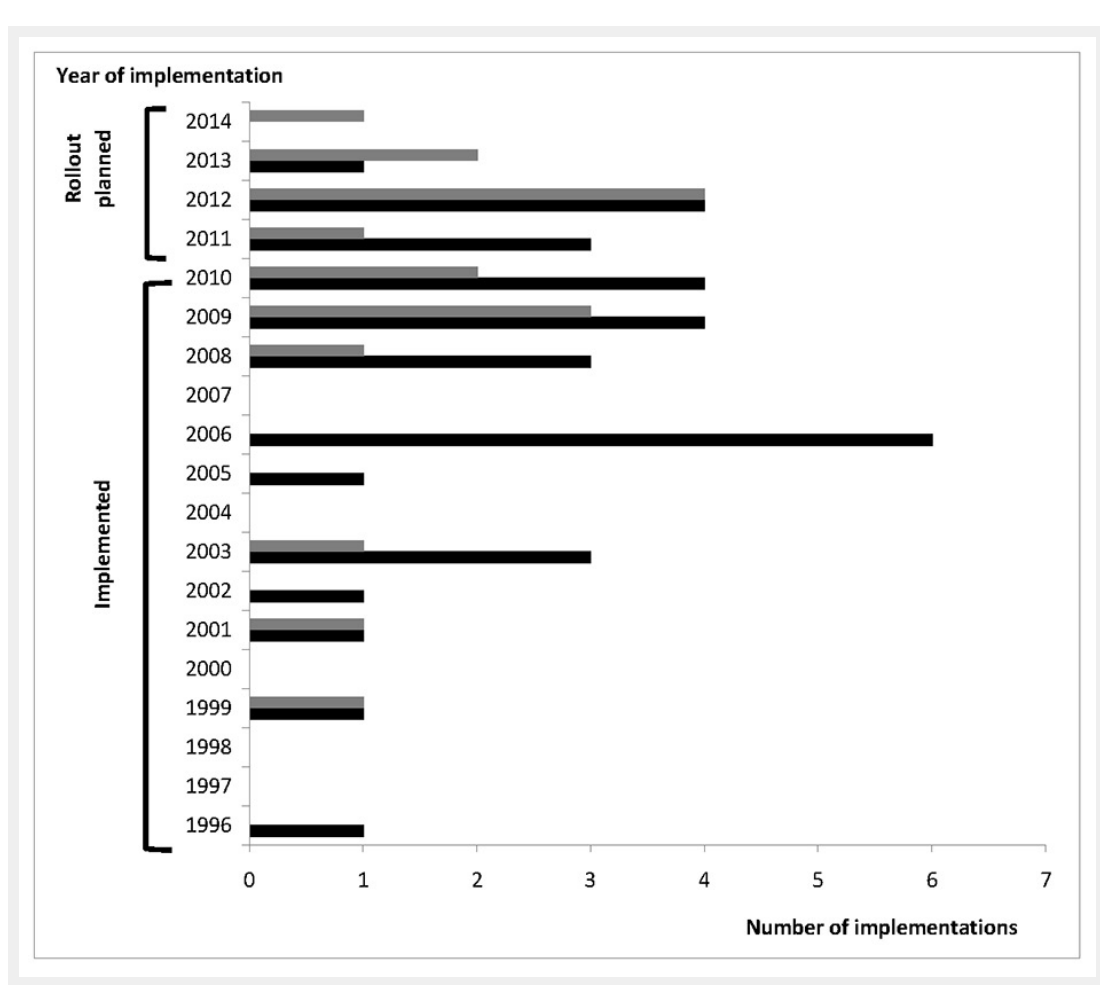
Figure 1 Number of implementations of CPOE and CDSS over the years. Gray bars = implementation of clinical decision support (CDSS) systems; black bars = Implementation of computerised physician order entry (CPOE)